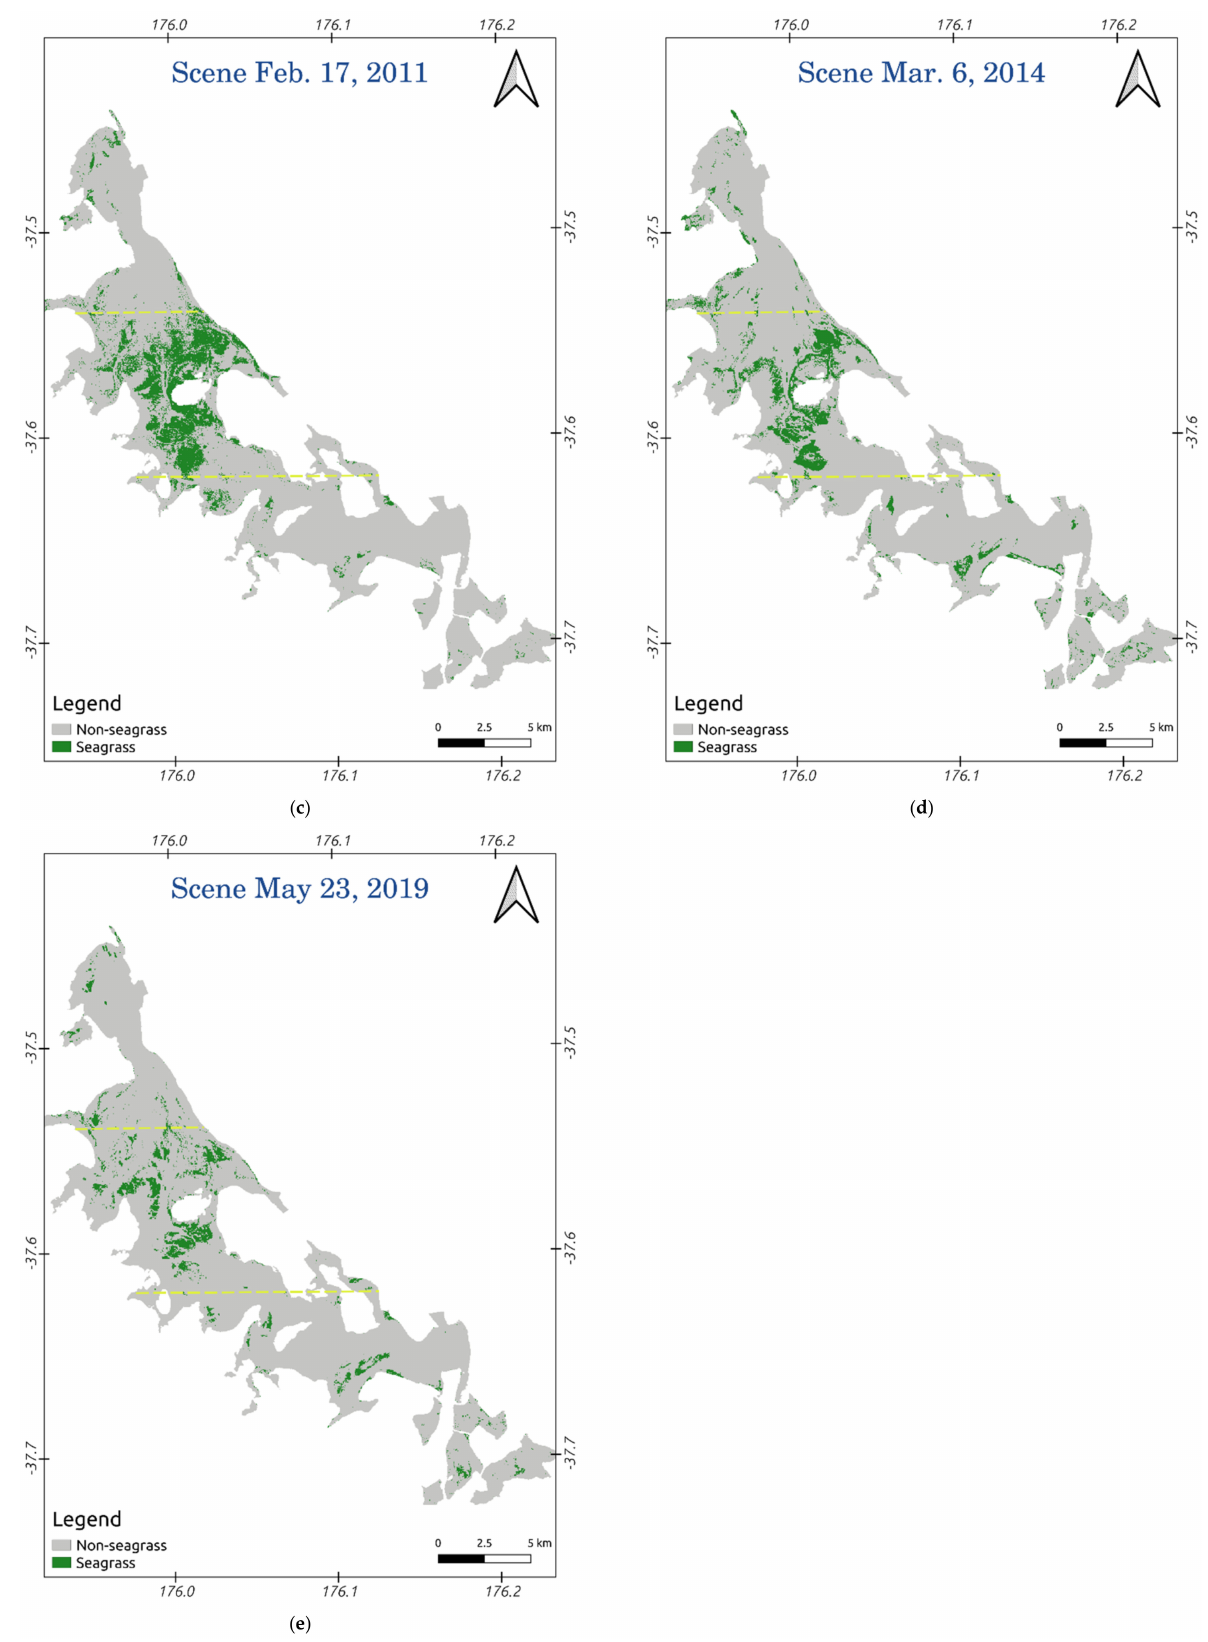
Figure 3. Seagrass distribution in the years 1990, 2001, 2011, 2014, and 2019 ( a – e ) using the CB model (yellow lines indicate the boundaries of the northern, central, and southern